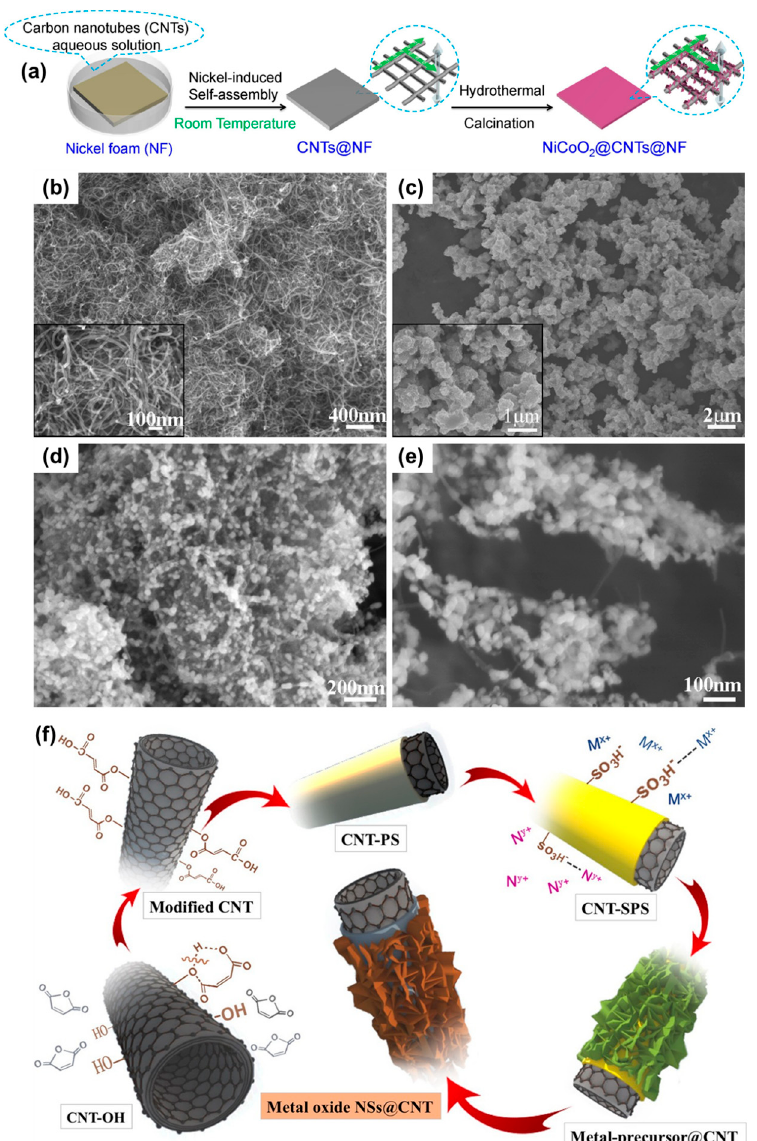
Figure 7. ( a ) Schematic illustration of the fabrication process of the NiCoO 2 @CNTs@NF integrated electrode. Reproduced with permission from ref. [3]. Copyright 2021 Elsevier. ( b – e ) SEM images of ( a ) pure CNT, ( b ) pure NiCoO 2 , and ( c , d ) NiCoO 2 @CNT. Reproduced with permission from ref. [9].